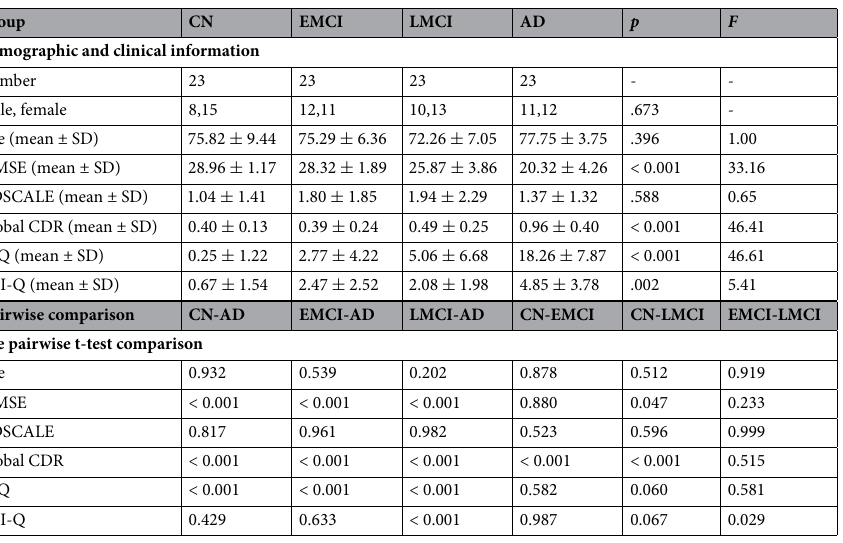
Table 2. Demographic and clinical information of the studied groups is shown in the top table. The pairwise t-test comparisons of the clinical information are presented in the bottom